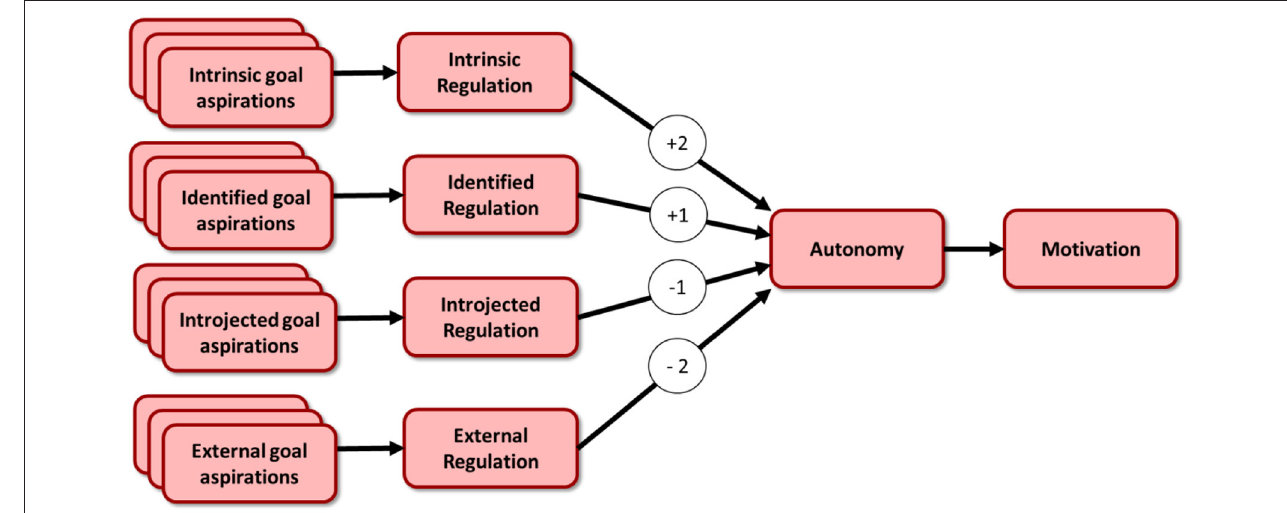
FIGURE 2 | The self-determination theory